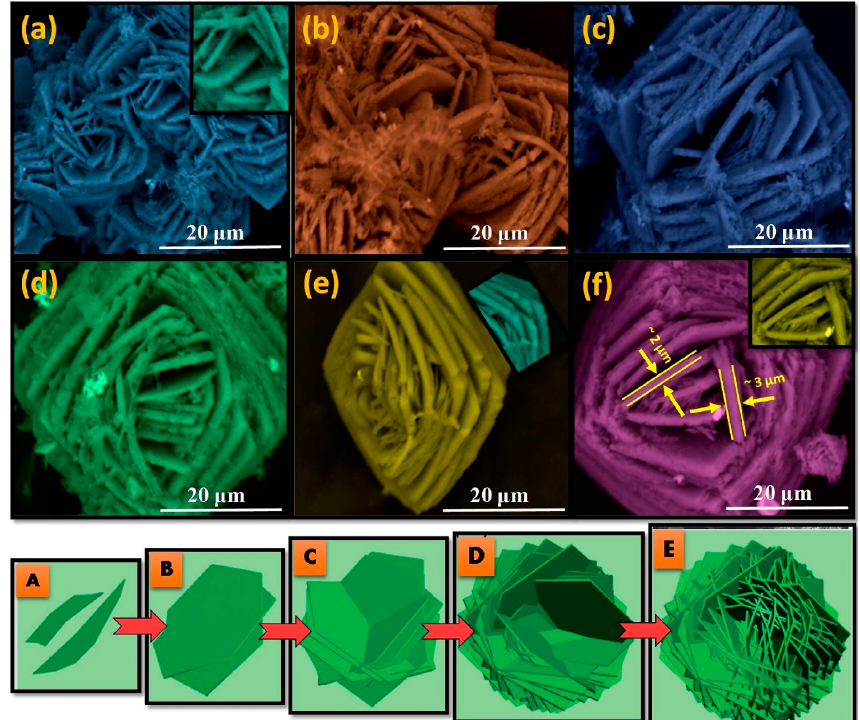
Figure 17. EM images of CeO 2 :Eu 3+ (3 mol%) NPs prepared with different reaction times in ethanol ( a ) 2 h, ( b ) 4 h, ( c ) 6 h, ( d ) 8 h, ( e ) 10 h and ( f ) 12 h with 30% w / v of EGCG at 180 °C, and ( A – E ) depict the proposed growth mechanism of the hierarchical morphology. EGCG is epigallocatechin-3-gallate [141]. Reprinted from Deepthi, N.H.; Darshan, G.P.; Basavaraj, R.B.; Prasad, B.D.; Nagabhushana, H. Large-scale controlled bio-inspired fabrication of 3D CeO 2 :Eu 3+ hierarchical structures for evaluation of highly sensitive visualization of latent fingerprints. Sens. Actuators B Chem. 2018 , 255 , 3127–3147, with permission from Elsevier.